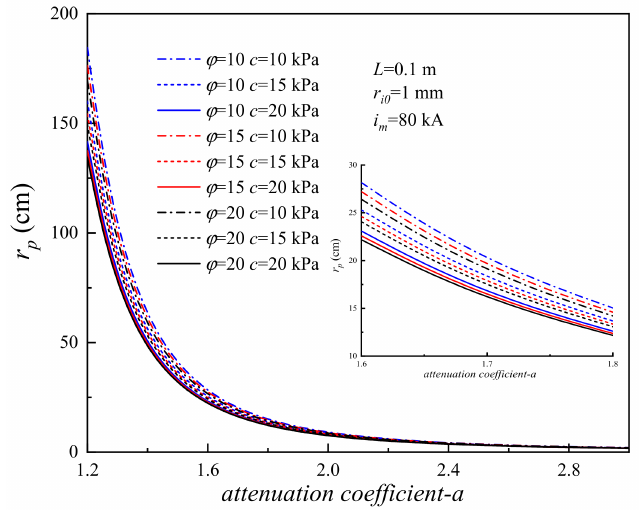
Figure 14. Effect of attenuation coefficient a on the